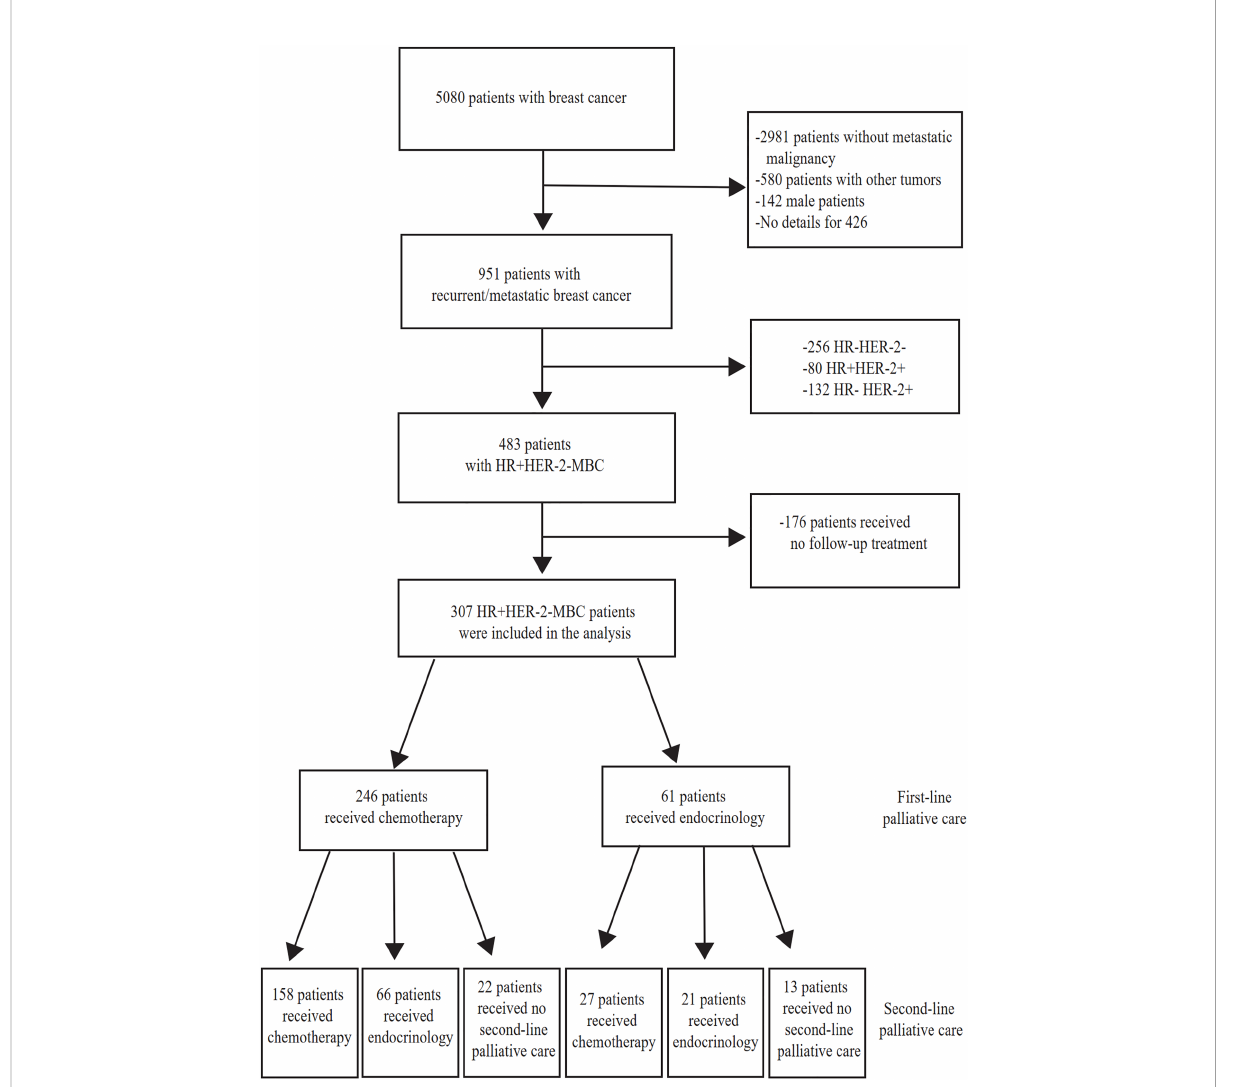
FIGURE 1 Study fl ow chart. MBC, Metastatic Breast Cancer. HR+, Hormone-receptor positive. HR-, Hormone-receptor negative. HER-2-, HER-2 negative. HER-2+ HER-2 is